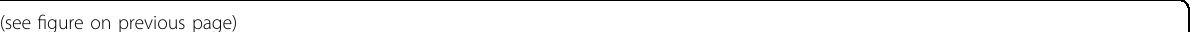
Fig. 3 In vitro and in vivo studies showing LNC-SNO49AB functioned as a pro-leukemic lncRNA in leukemia. a qRT-PCR analysis of LNC- SNO49AB expression in normal ( n = 15) and leukemia bone marrow ( n = 94) samples. Data were normalized to GAPDH mRNA. *** P < 0.001 by Mann- Whitney test. b qRT-PCR analysis of LNC-SNO49AB in 19 pairs of patients with leukemia at preliminary diagnosis and complete remission (CR). Data were normalized to GAPDH mRNA. *** P < 0.001 by Wilcoxon matched-pairs signed rank test. c , d Effects of knocking d own LNC-SNO49AB expression by siRNA on cell proliferation ( c ) and the cell cycle ( d ). Values are the mean ± SEM of three independent experiments. *** P < 0.001 by Student ’ s t test. e , f Effects of knocking down LNC-SNO49AB expression by smart silencing of cell proliferation ( e ) and 2 μ M ATO (arsenic trioxide)-induced apoptosis ( f ) in RS4;11 and MOLM13 cells. Values are the mean ± SEM of three independent experiments. ** P < 0.01, and *** P < 0.001 by Student ’ s t test. g Morphology of colonies of leukemia cells upon siRNA-mediated knockdown of LNC-SNO49AB. Scale bars, 100 μ m. Error bars re fl ect ±SEM of three independent experiments. ** P < 0.01, *** P < 0.001. h , i Effects of forced expression of LNC-SNO49AB on cell proliferation ( h ) and arrest of the cell cycle ( i ) in leukemia cells. Values are the mean ± SEM of three independent experiments. *** P < 0.001 by Student ’ s t test. j Wright-Giemsa staining of peripheral blood ( P B) and BM of mouse recipients of PBS, sh - NC cells or sh-LNC-SNO49AB RS4;11 cells. RS4;11 cells were indicated by the black arrows. Scale bars, 50 μ m. k Spleen photographs from transplant mice (left) and the weight statistic at the time of the fi nal analysis (right). Values are the mean ± SD of three independent experiments. ** P < 0.01 by Student ’ s t test. l Flow cytometry analysis of GFP + cells in blood, BM, spleen and liver. Values are the mean ± SEM of three independent experiments. * P < 0.05, and *** P < 0.001 by Student ’ s t test. m Effect of knocking down LNC- SNO49AB expression on the survival of the recipient mice. Kaplan-Meier curves are shown for two cohorts of transplanted mice, sh-NC and sh-LNC- SNO49AB cells. Six mice per group. The P -values were calculated by log-rank